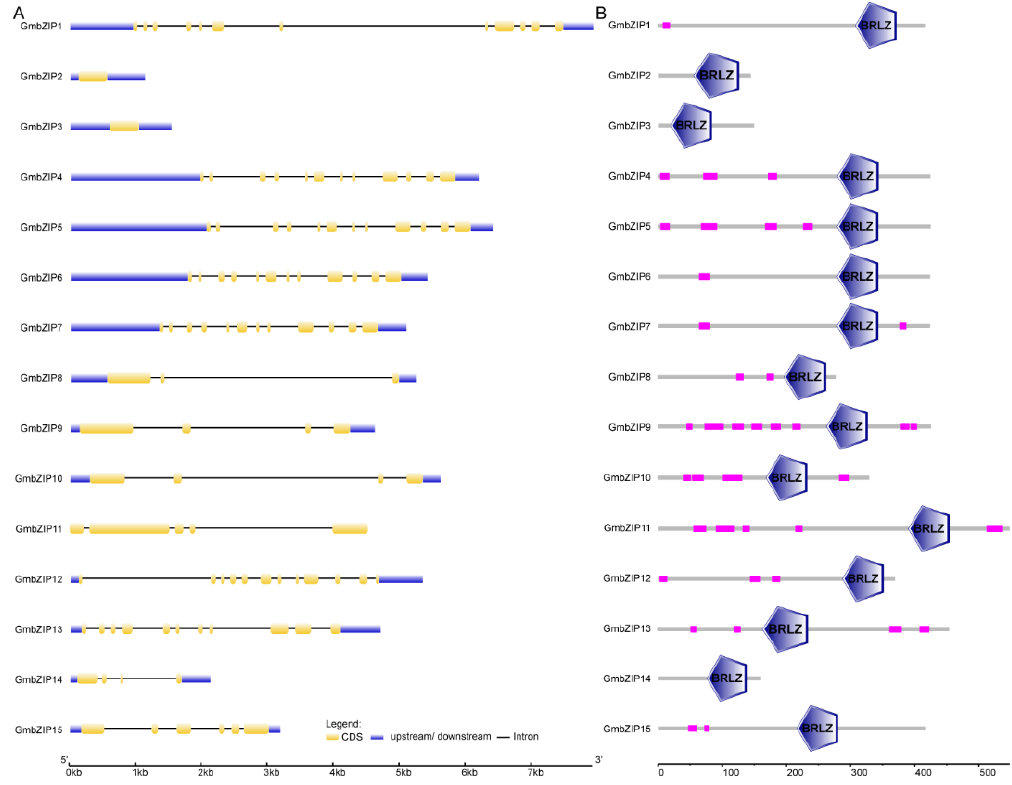
Figure 2. Gene structure analysis of soybean bZIPs. ( A ) Intron–exon structures of 15 soybean bZIP genes. ( B ) Protein structure analysis of 15 soybean bZIP genes.